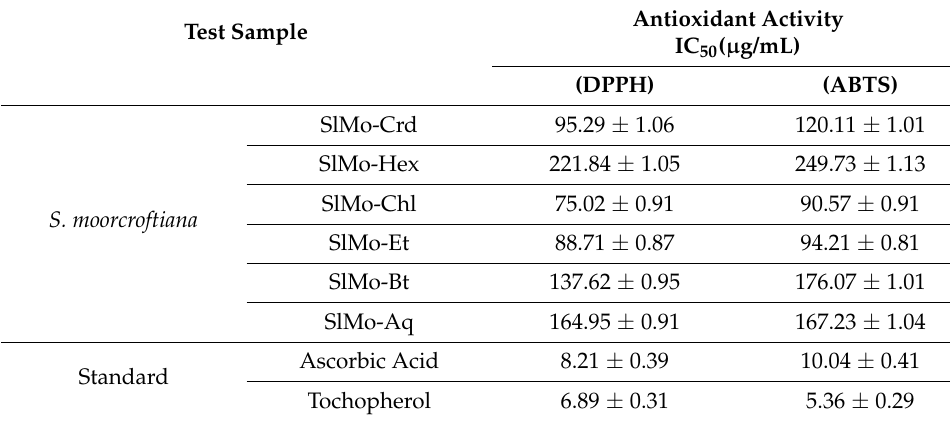
Table 2. Antioxidant potential extracts of S. moorcroftiana